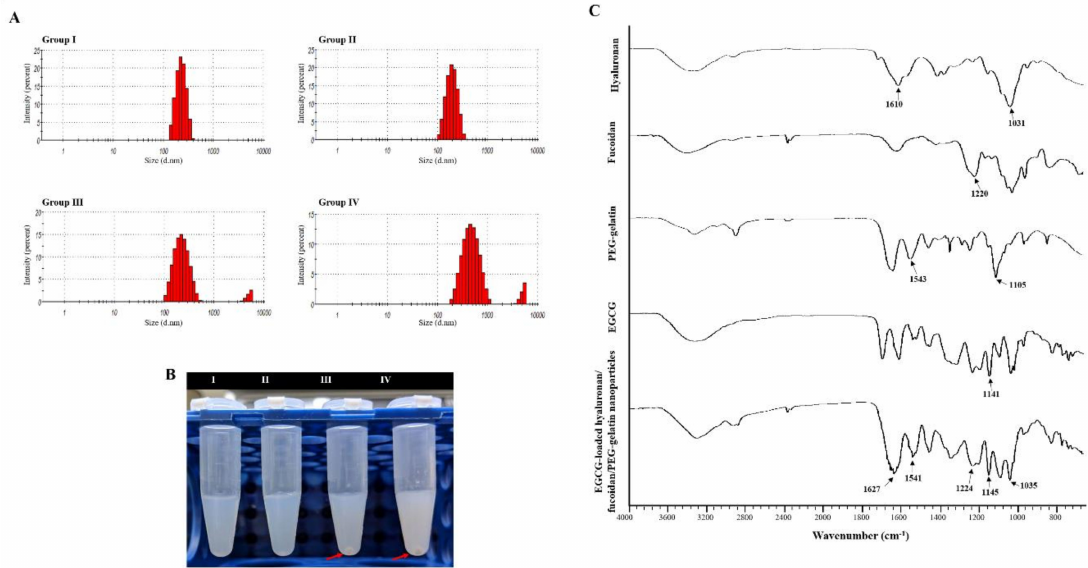
Figure 3. Characteristics of the prepared epigallocatechin-3-gallate (EGCG)-loaded hyaluronan / fucoidan / PEG–gelatin nanoparticles. ( A ) Particle size distributions; ( B ) Liquid morphology of EGCG-loaded hyaluronan / fucoidan / PEG–gelatin nanoparticles produced with di ff erent hyaluronan / fucoidan concentrations, as follows: Group I: 0.625:0.625:3.750:2.000; Group II: